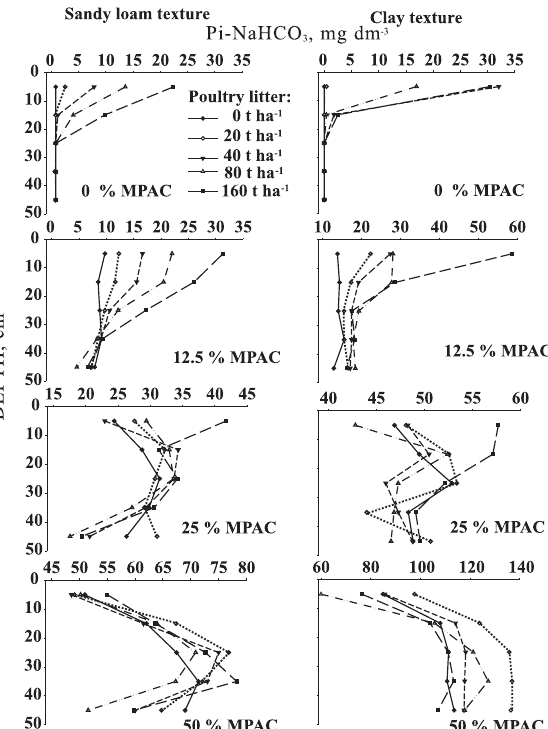
ring.Figure 4. Inorganic phosphorus contents (Pi) extracted by NaHCO (Pi-NaHCO ) in samples 3 3 of two Latosols with sandy loam and clay texture, prefertilized with increasing mineral P rates as related to the poultry litter rates applied in the top